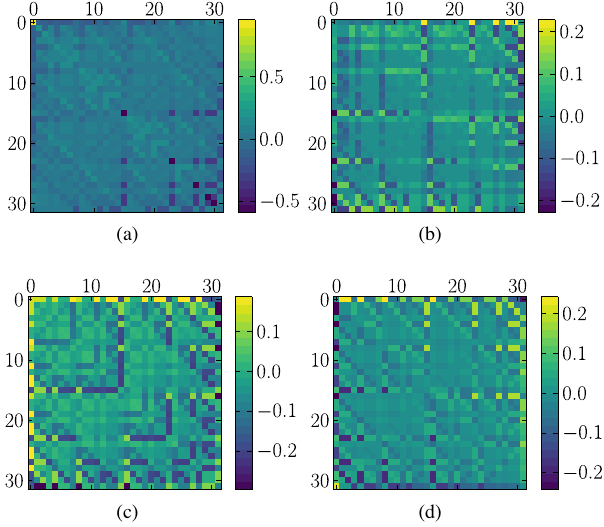
FIG. 7. Using Algorithm 1, we obtain a heat map for the measurement observables X 1 and X 2 for the depolarized five- qubit 3D GHZ state, under a depolarizing strength g ¼ 0 . 3 . We plot the real and imaginary parts separately. The Hermiticity of these observables is clearly illustrated. (a) Re ð X 1 Þ (b) lm ð X 1 Þ (c) Re ð X 2 Þ (d) lm ð X 2 Þ